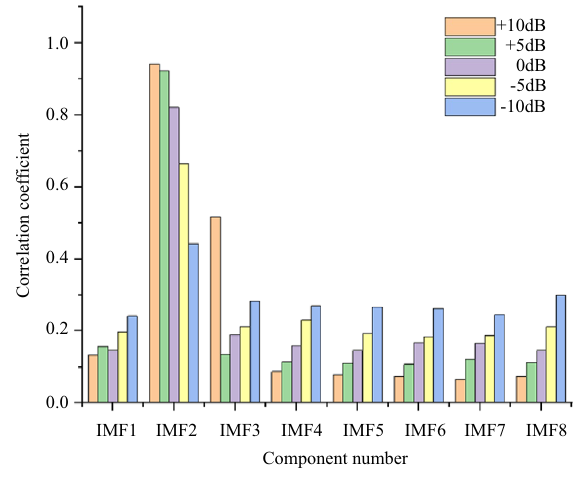
Figure 3. Correlation coefficients corresponding to different IMFs.